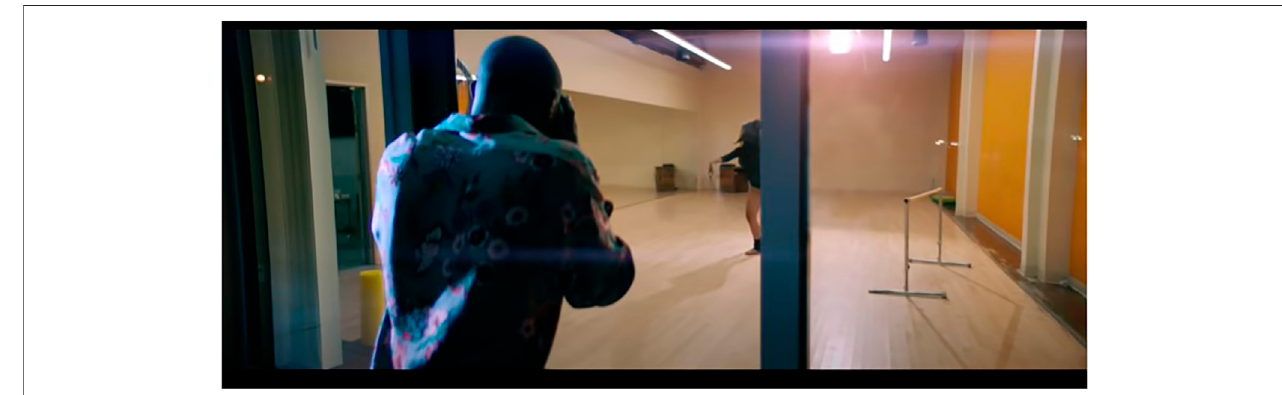
FIGURE 3 | Afrobeats artist, Davido, depicted as voyeuristically watching a woman dancing in a well-lit dance studio [screenshot taken from Fall (Of fi cial Music Video): https://www.youtube.com/watch?v (cid:1) 3Iyuym-Gci0].